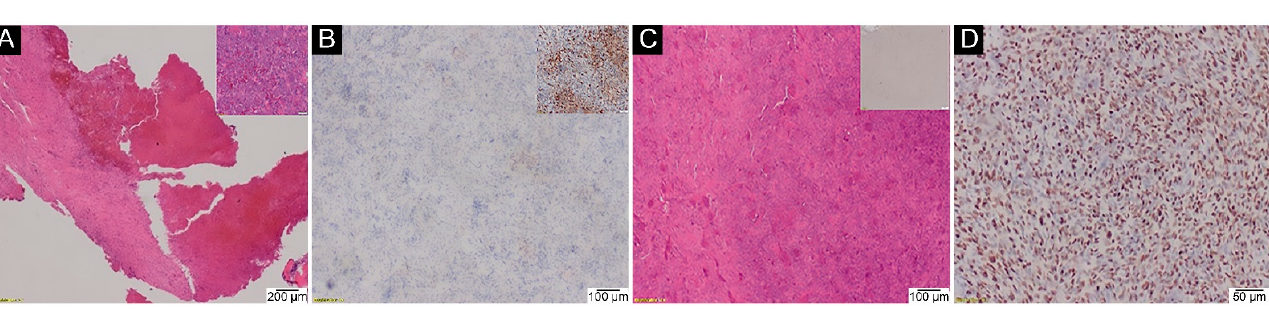
Figure 3. GCTB with p.Gly35Val substitution. ( A ) positive assay with an anti-histone 3.3 G34V an- tibody (IHC, 40×); ( B ) negative assay with an anti-histone 3.3 G34W antibody in the same case (IHC, 40×).